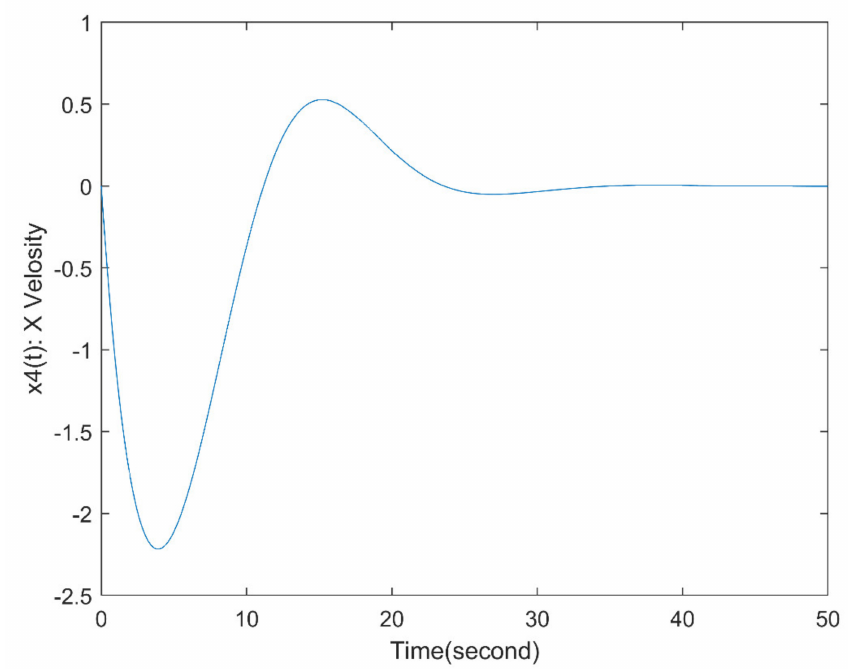
Figure 5. Response of state x 4 ( t )